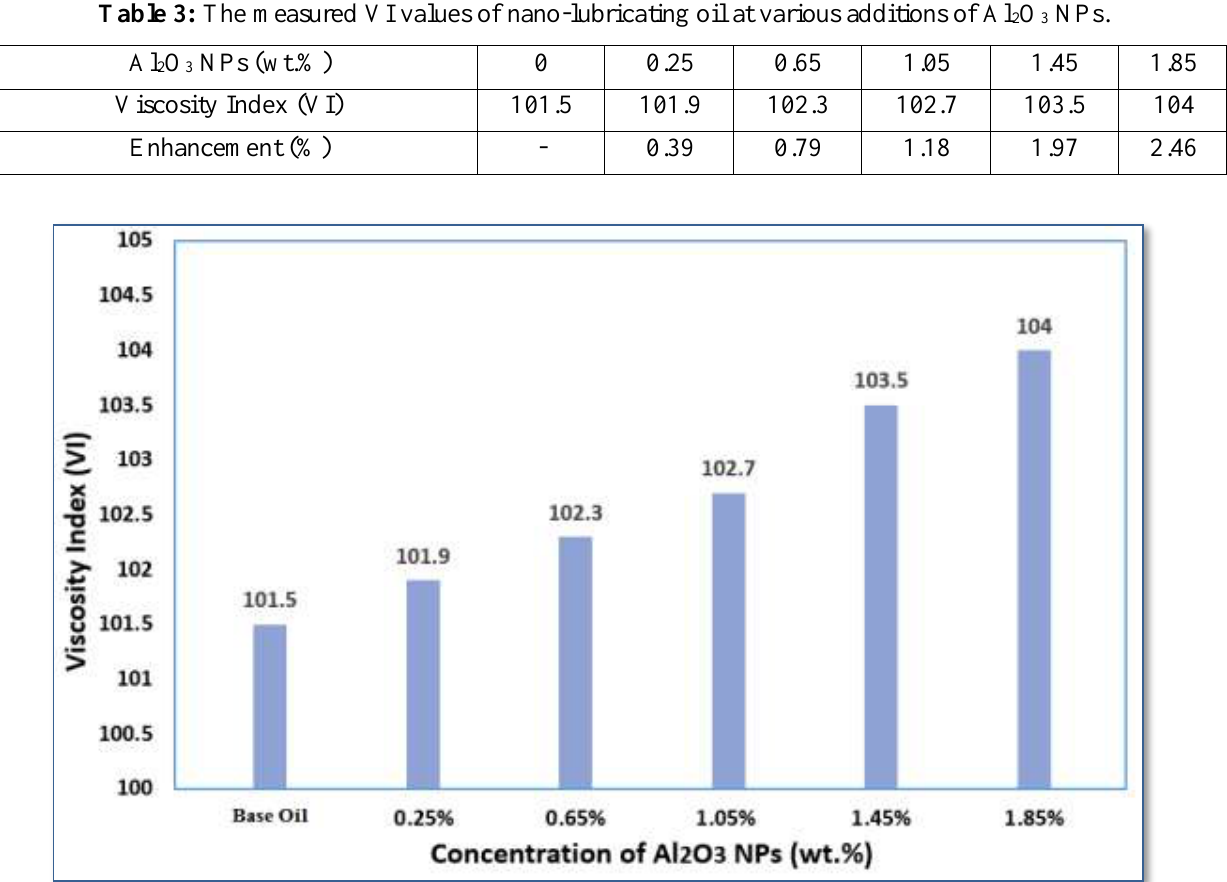
Figure 6: Influence of Al 2 O 3 NPs additions on the viscosity